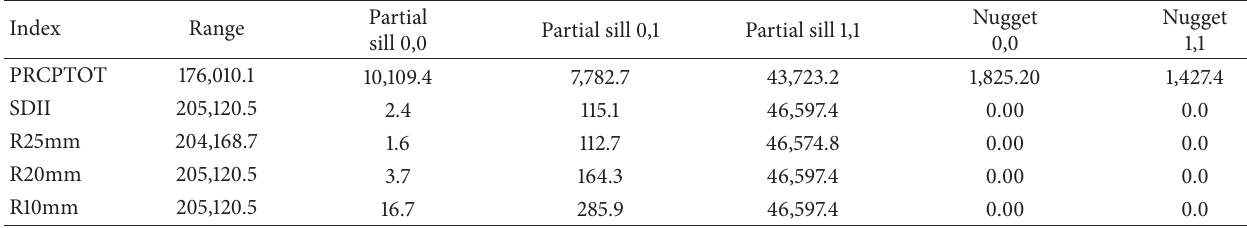
Table 4: Semivariogram parameters for significant indices by